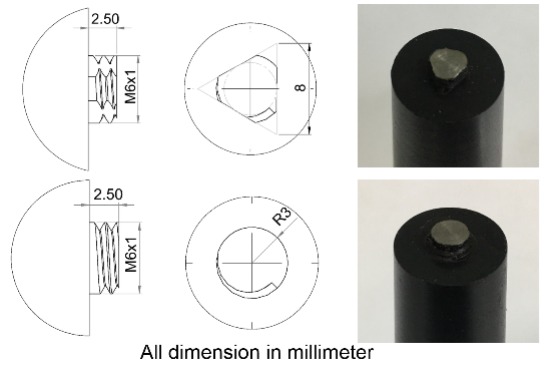
Figure 1. Cylindrically threaded tool with three flat faces (3L) and a cylindrical groove (CG).